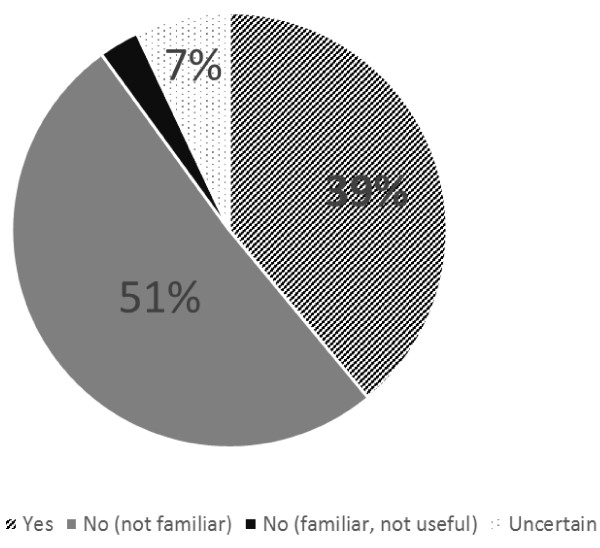
Responses to “Have the KDOQI/KDIGO CKD guidelines been helpful in managing your CKD patients?” N = 151.